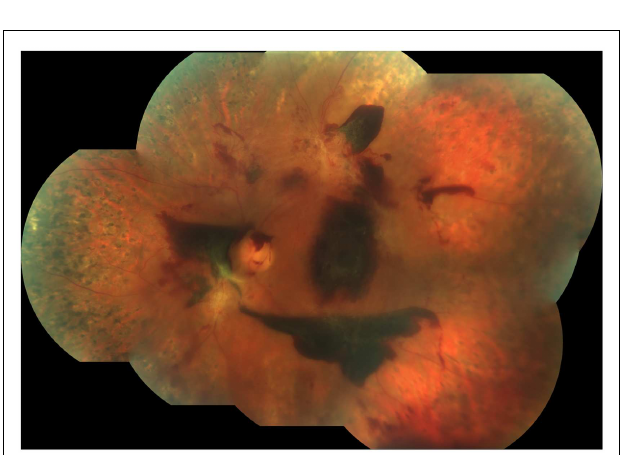
FIGURE 3 | Fluorescein angiography obtained from the right eye of a patient with non-proliferative diabetic retinopathy . Note diffuse retinal non-perfusion and ischemia in the midperipheral retina in the absence of neovascularization.